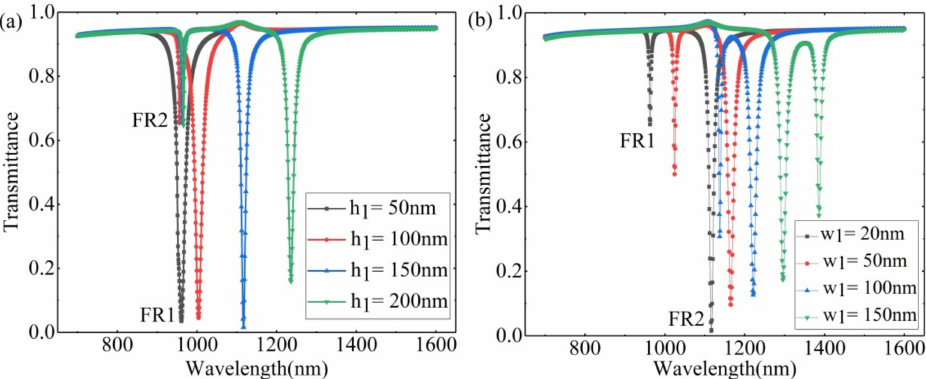
Figure 6. ( a ) The transmission spectra of different h 1 ; ( b ) the transmission spectra of different w 1 .